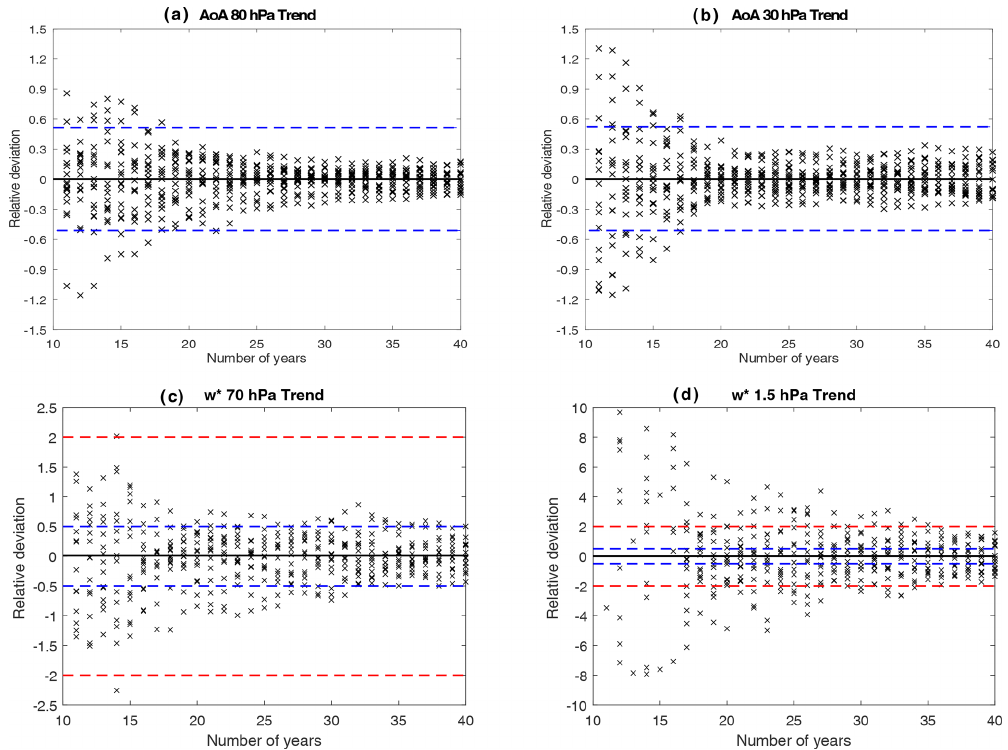
Figure 7. Trends from 18 ensemble members of UKESM1-0-LL for periods of increasing length ( x axis), ranging from 11 years (1975– 1985) to 40 years (1975–2014). Trends of individual ensemble members (crosses) are displayed as relative deviations from the ensemble mean trend. Panels (a) and (b) show trends in AoA and panels (c) and (d) show trends in upwelling; both variables are at the same regions as in Fig. 5. Horizontal dashed lines mark fixed values to ease comparison across